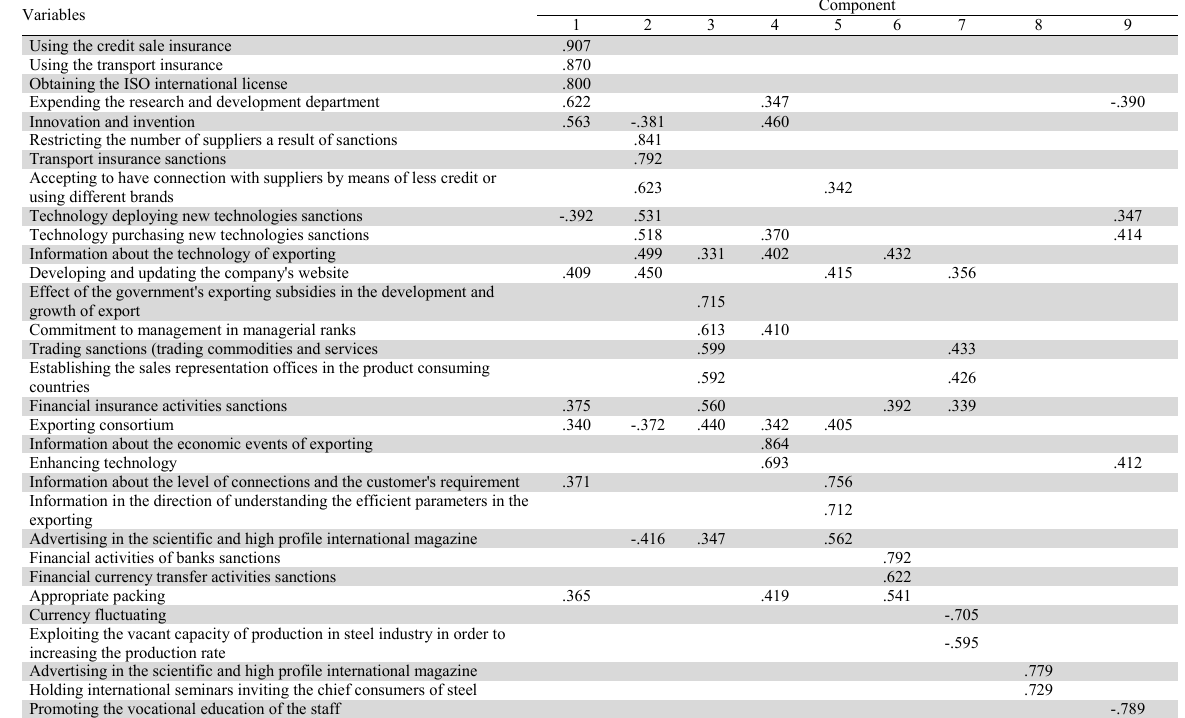
The results of PCA after Varimax rotation for export activties Variables